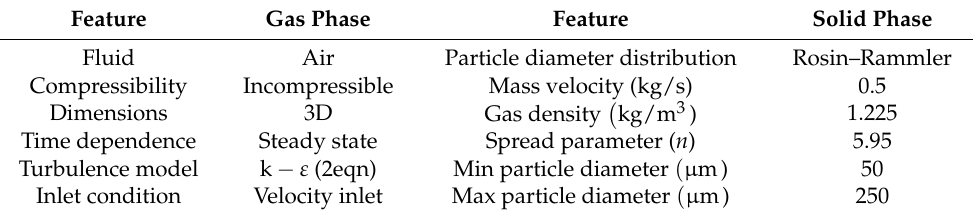
Table 2. Setting of parameters for the simulation calculation.